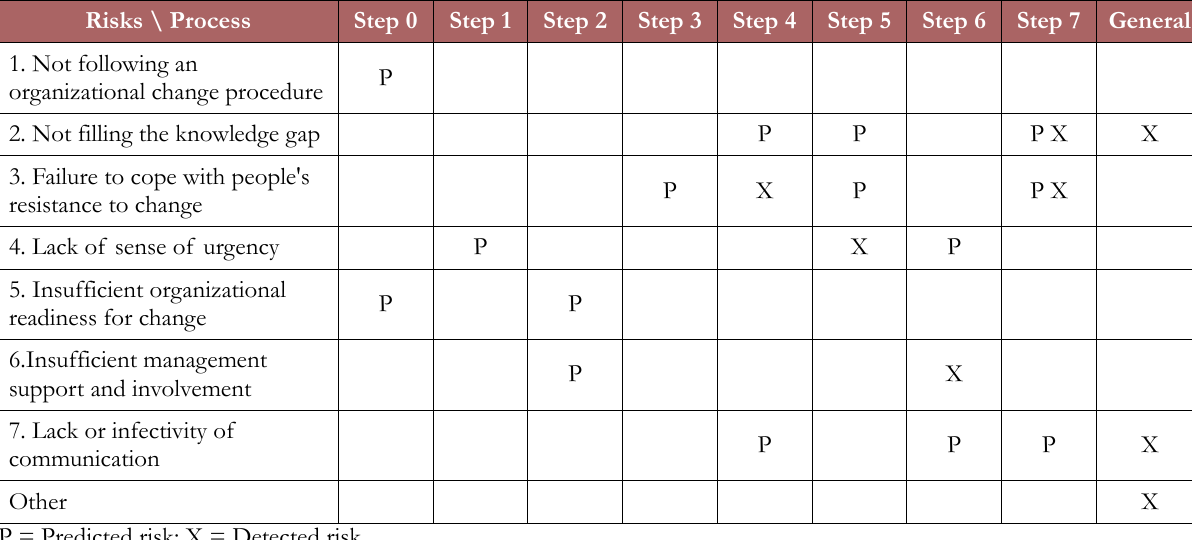
Table 3. Summary of risks predicted and detected in each step of the change